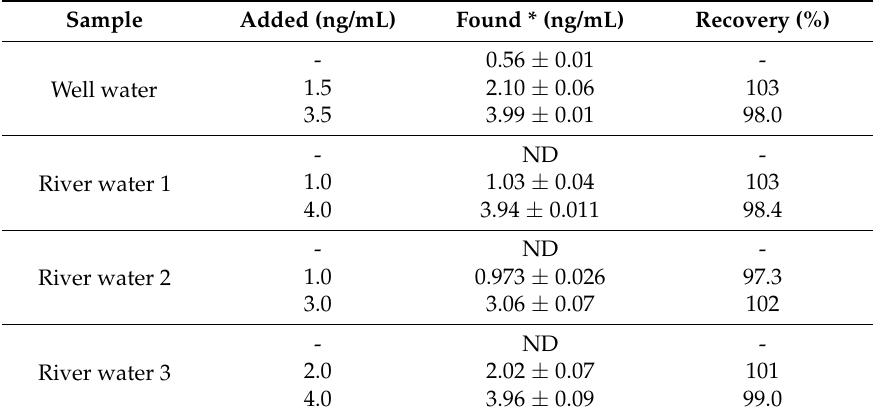
Table 4. Determination results of nickel in the water